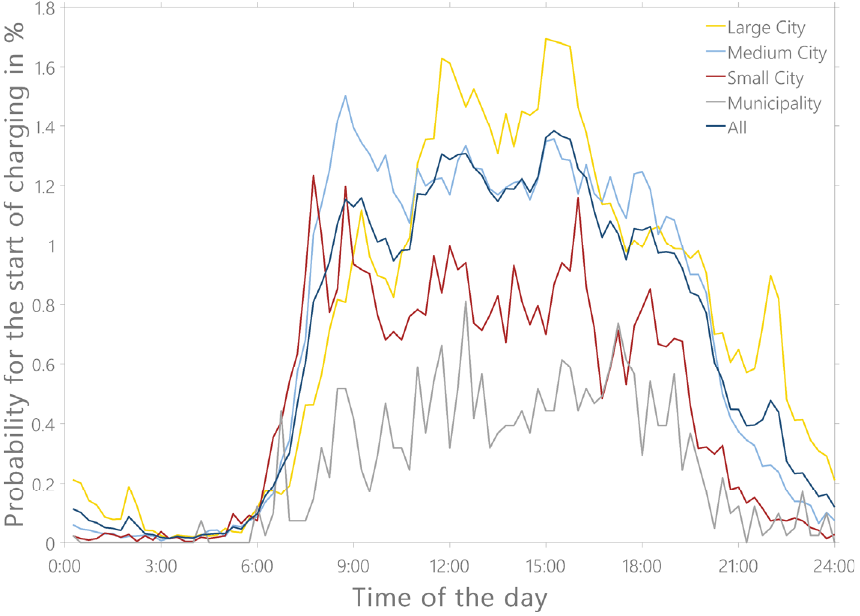
Figure 6. Probabilities for the start of a charging process classified by region in 15 min resolution.